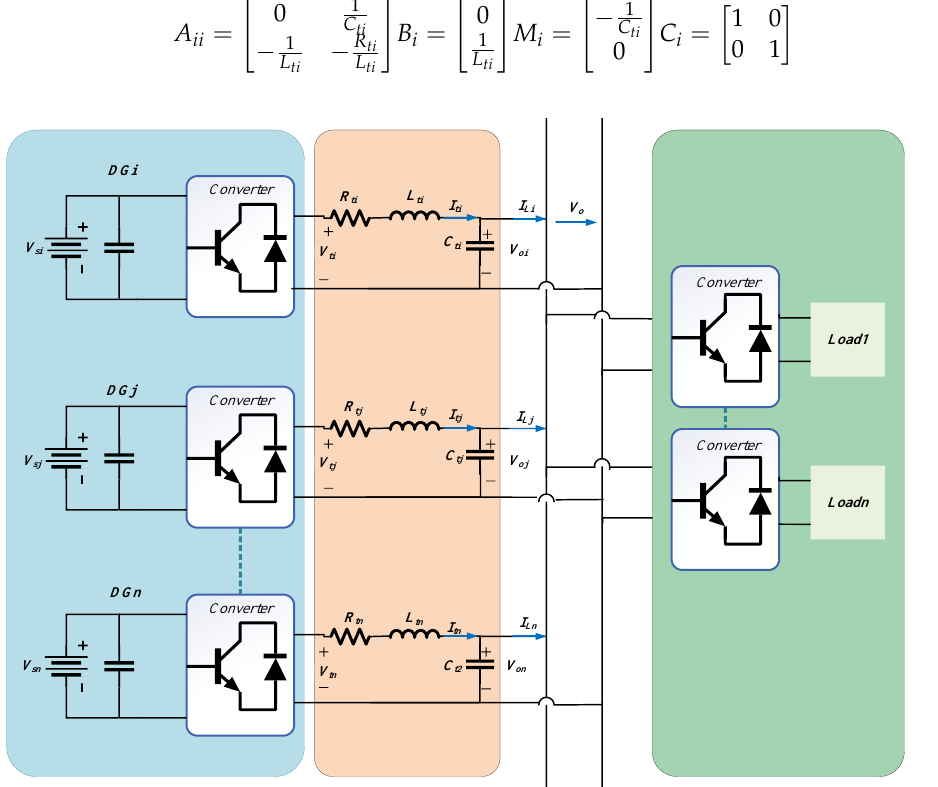
Figure 1. A diagram of a typical